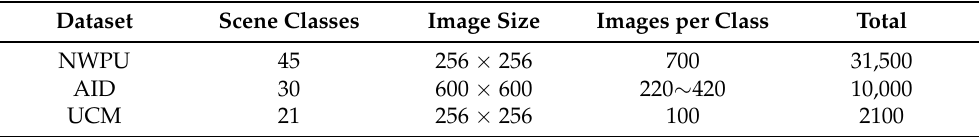
Table 1. Characteristic of the datasets.